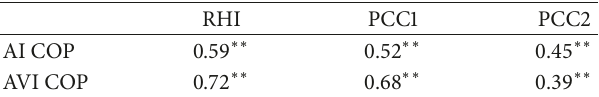
Table 3: The Pearson correlation coefficient between COP and